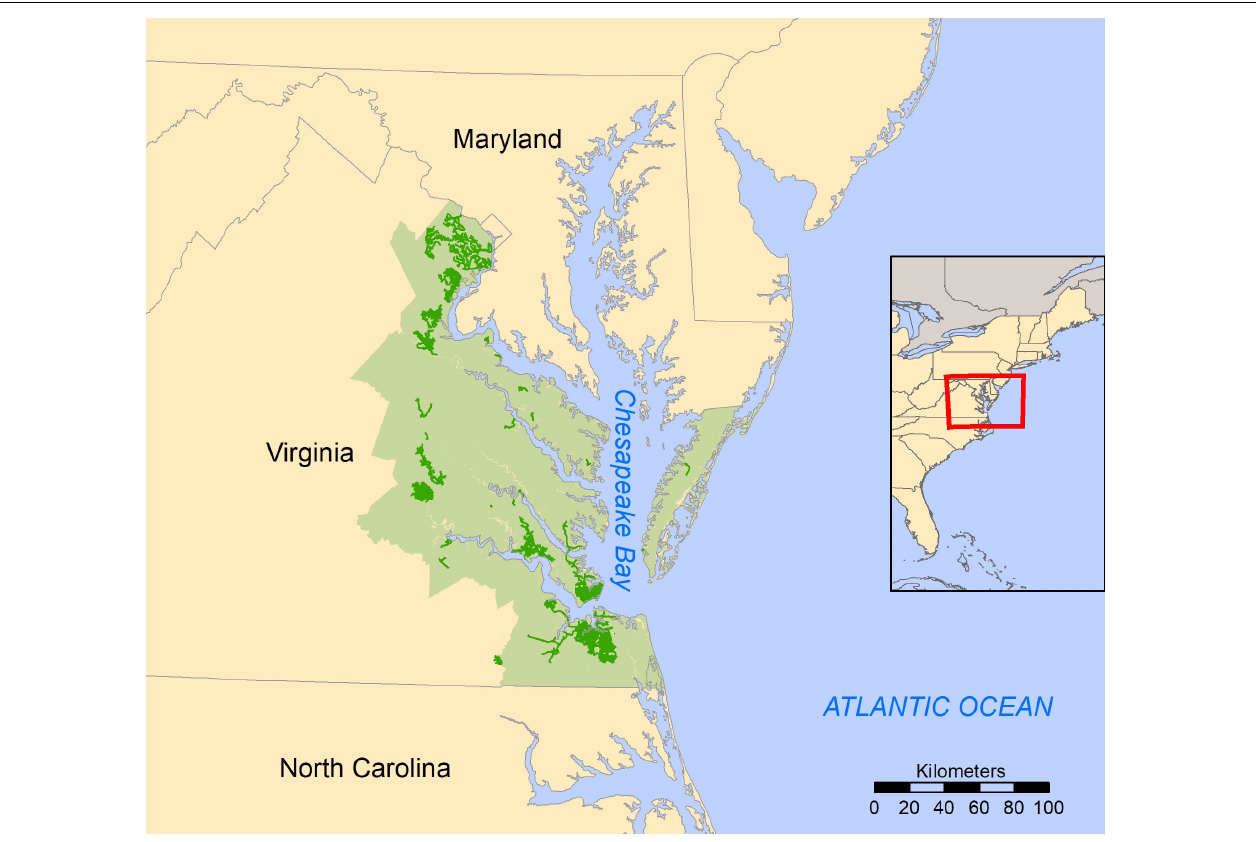
FIGURE 1 | Map of the study area, Virginia United States. Urban areas are designated by the sewer lines (shown in dark green) and were excluded from the study. All light green areas were included in the